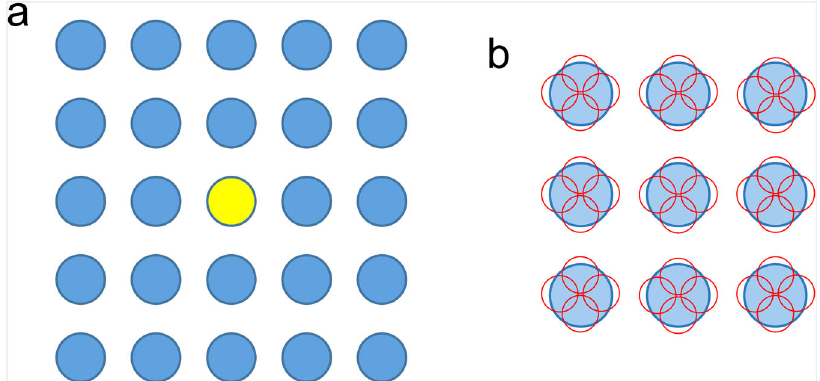
Fig. 1 Schematic diagram of data taking for SPA through image shifts. a Stage shift is only used to locate the central hole in yellow, and image shifts are applied for data taking from other 24 holes in this example. b Multiple images stacks, 4 in this example, are recorded from different areas shown in small red circles in one hole. Pre-check of the surrounding holes is unsuitable for fast collection of images stacks from each